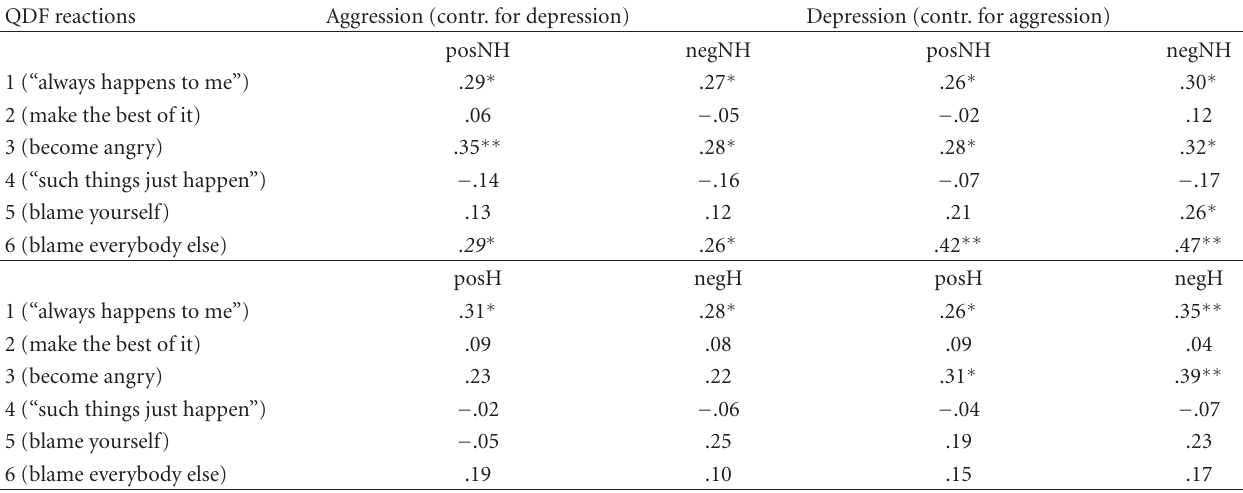
Table 9: Partial correlations of reactions in QDF scales with the personality factors of aggression and depression, controlling for depression and aggression, respectively, (legend see Table